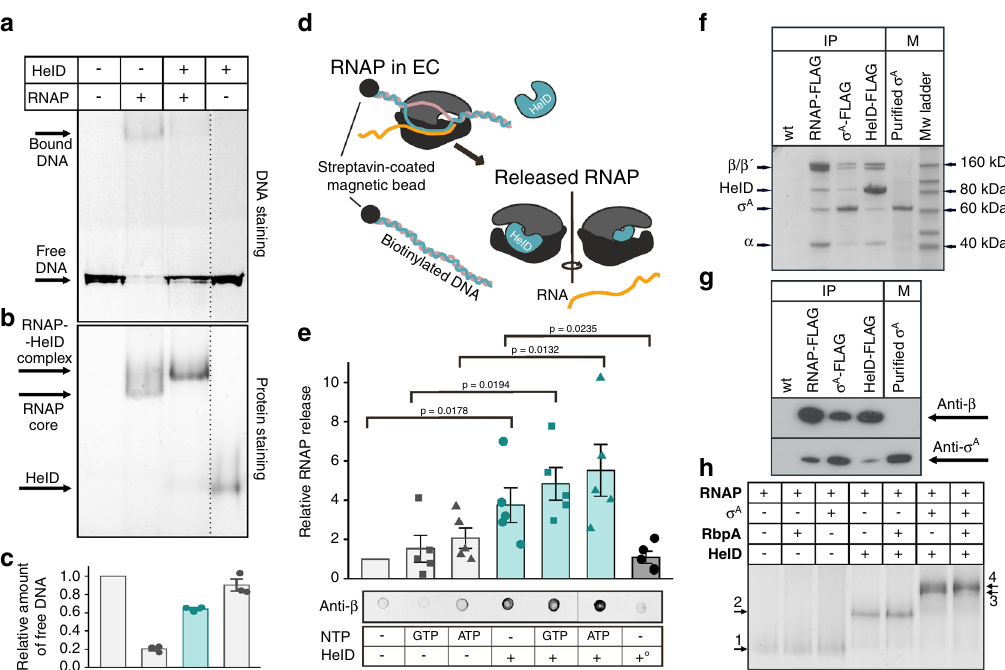
Fig. 4 Binding of Msm HelD to RNAP and its effects on DNA – RNAP interactions. a DNA binding to RNAP - EMSA - binding of 300 bp DNA to the Msm RNAP core and the effect of HelD. b The same gel as above but stained for proteins. The dotted line shows where the gel was electronically assembled. c Quantitation of EMSA – the bars here (the amount of unshifted DNA) and in e are mean values from at least three independent experiments, the error bars show ±SD, the individual symbols show values of individual independent replicates. The leftmost bars were set as 1 and the other values within each graph were normalized relative to this bar. The turquoise bars here and in e indicate the addition of HelD. d EC disassembly - scheme: ECs were assembled on DNA:RNA scaffolds and challenged with HelD and/or NTPs. RNAP released into buffer was quantitated by western dot blots. e Quantitation of EC disassembly from fi ve independent experiments. Representative primary data are shown below the graph. Presence/absence of individual components is indicated. + ° indicates heat-inactivated HelD. The statistical signi fi cance in e for the indicated combinations was p < 0.05 (one-sided Student ’ s t -test; exact p -values are written in the graph). f Representative SDS-PAGE of immunoprecipitations of Msm RNAP ( β ), σ A , and HelD. All proteins were FLAG fusions, the antibody was anti-FLAG. Wt, a strain without any FLAG fusion. The identity of the bands was con fi rmed by mass spectrometry. IP, immunoprecipitation; M, markers. The experiment (biological replicates) was performed 3× with the same result. g Representative western blot of IPs of FLAG-tagged Msm RNAP ( β ), σ A , and HelD. Antibodies against RNAP β and σ A were used to detect the presence of proteins in complexes. M, marker – puri fi ed σ A . The experiment was performed twice with the same result. h In vitro protein interactions - EMSA. Proteins were detected by Simply blue SafeStain. In all cases, RNAP was fi rst reconstituted with HelD and then with RbpA and/or σ A . A small, but a reproducible shift was observed after the addition of both RbpA and σ A to RNAP – HelD, indicating the presence of all proteins in one complex. Numbered arrows indicate complexes with different protein composition (determined by mass spectrometry). In some cases, complexes with different protein compositions displayed the same migration in the gel: 1. RNAP, RNAP-RbpA; RNAP- σ A ; 2. RNAP – HelD, RNAP – HelD-RbpA; 3. RNAP – HelD- σ A ; 4. RNAP – HelD- σ A -RbpA. The experiment (biological replicates) was performed 3× with the same